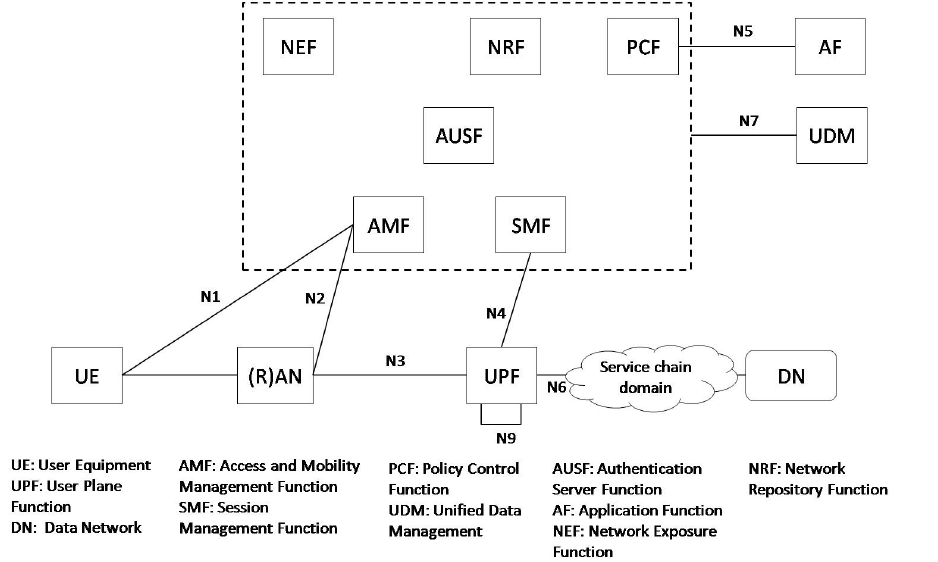
Figure 1. The 5G service-based